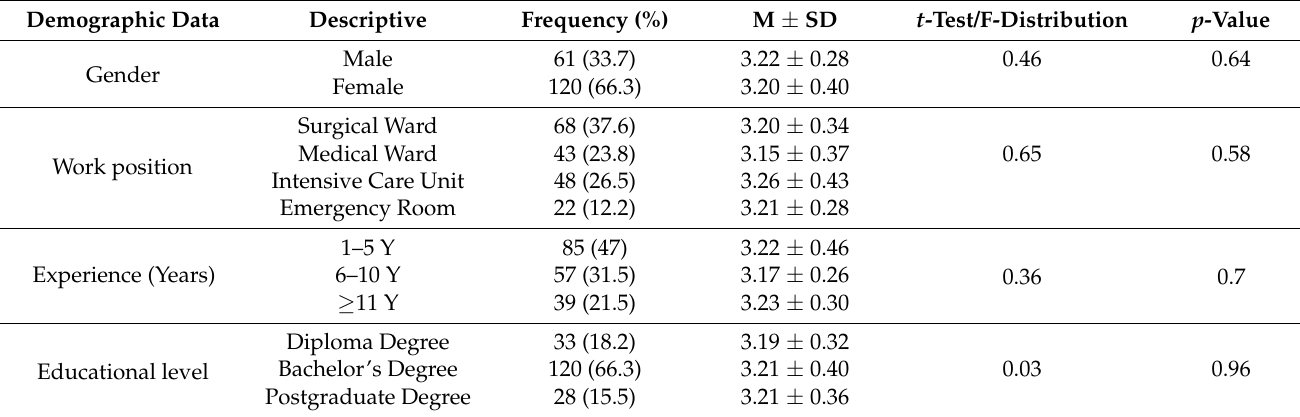
Table 2. Prosperities and the occurrence of burnout among nurses’ socio-demographic factors ( n = 181). Demographic